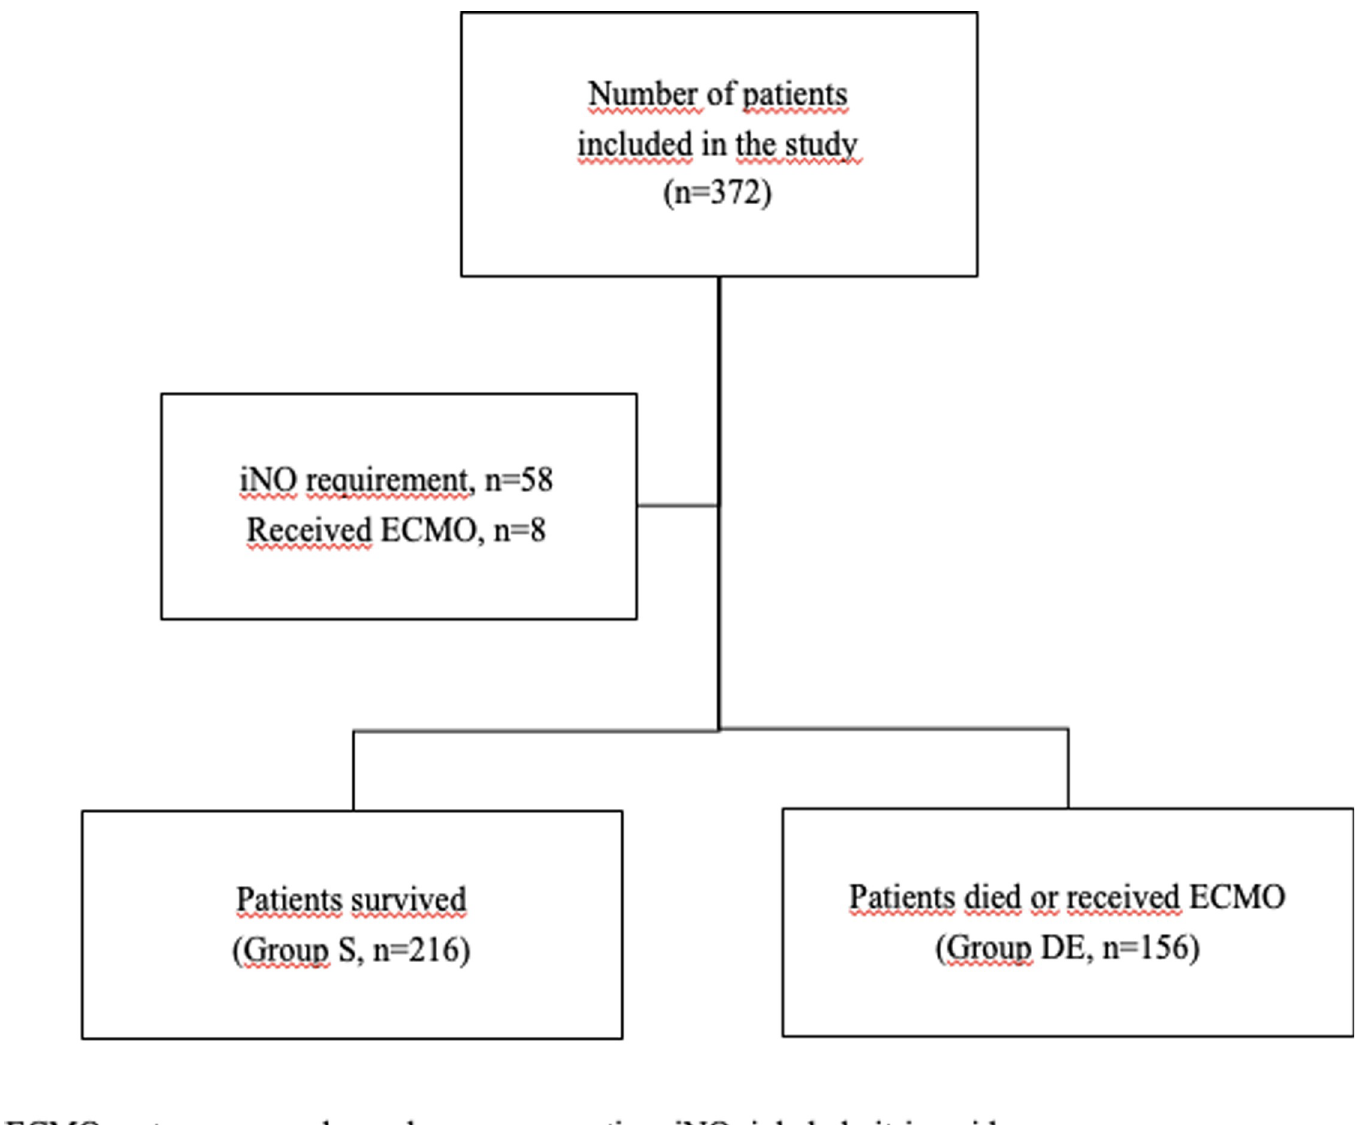
Fig 1. Flow chart of the